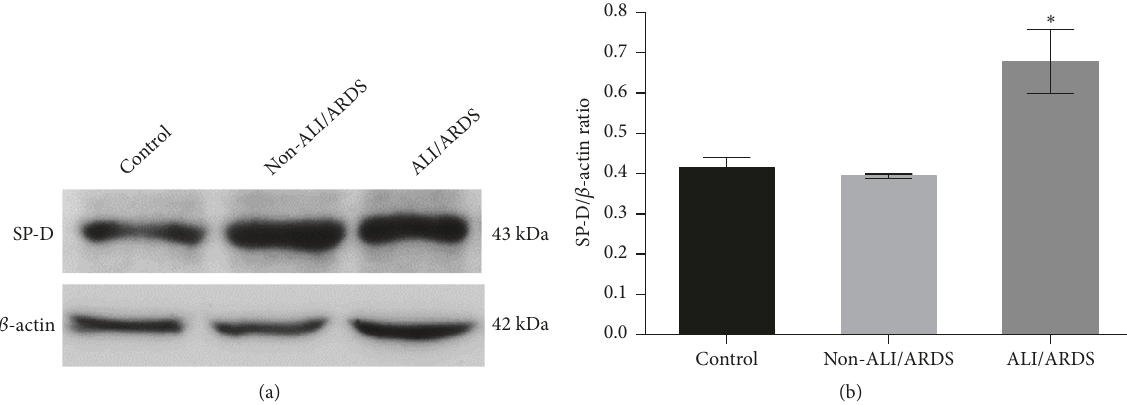
Figure 2: Western blot analysis of SP-D expression in the lung tissues from the malaria-infected mice with ALI/ARDS, malaria-infected mice in the non-ALI/ARDS group, and mice in the control group (n = 5 mice per group). (a) Representative immunoblot images for SP-D and (b) the quantification of SP-D expression by Western blot analysis. ∗ Significance of p < 0.05 compared among groups using Kruskal–Wallis